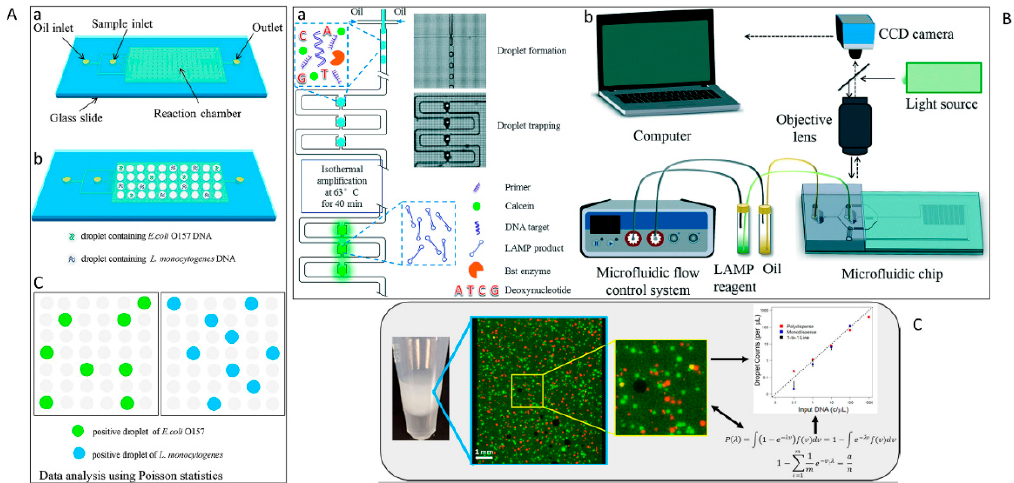
Figure 6. ( A ) Droplet digital PCR workflow: (a) fabrication of mineral oil saturated PDMS (OSP) microfluidic chip, (b) generation of droplets, (c) on-chip amplification followed by fluorescence readout, and (d) data analysis [96]. ( B ) (a) Schematic depiction of the assay for emulsion droplet array- based digital LAMP analysis. (b) eEperimental set up for result analysis [209]. ( C ) Multiplexing in